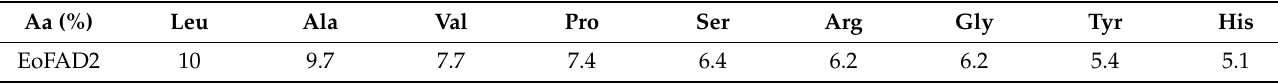
Table 6. Most frequent aa in the EoFAD2